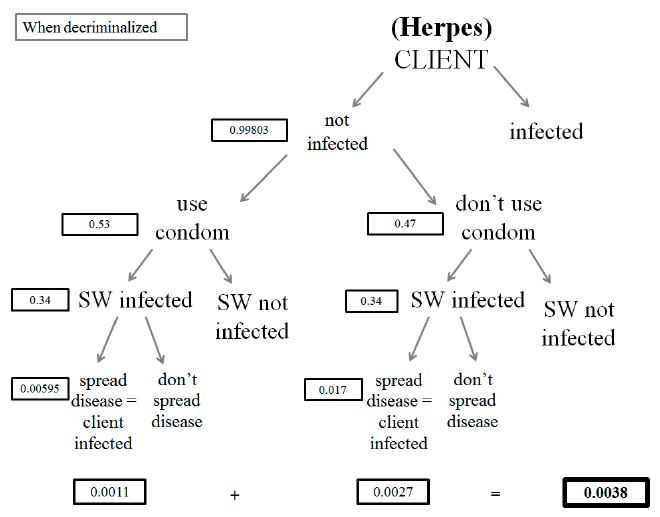
Figure A17. Risk of gonorrhea transmission to a client under decriminalization. Table A1. Annual income tax revenue and health sector savings per sex worker in sensitivity analysis, by variable modi- fied.